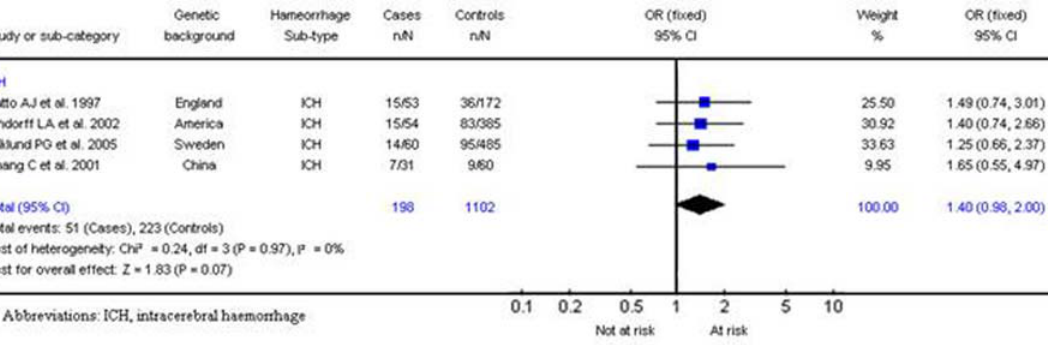
Figure 3. Results for SERPINE1 4G/5G and intracerebral haemorrhage of 5G allele homozygous (5G/5G) genotype.